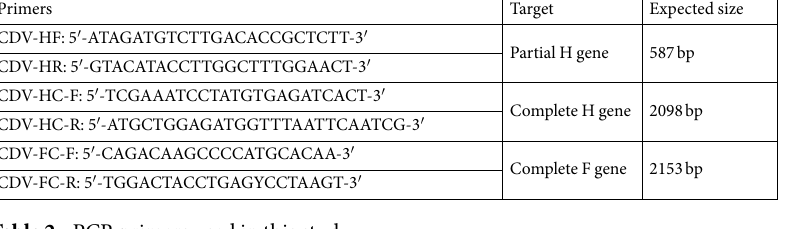
Table 2. PCR primers used in this